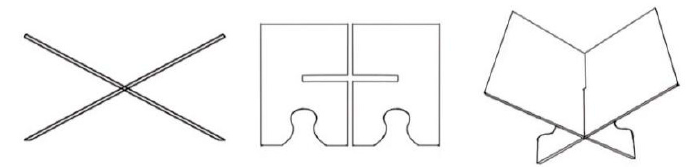
Figure 1. Visual sketch of the rehal, illustrated by researcher.